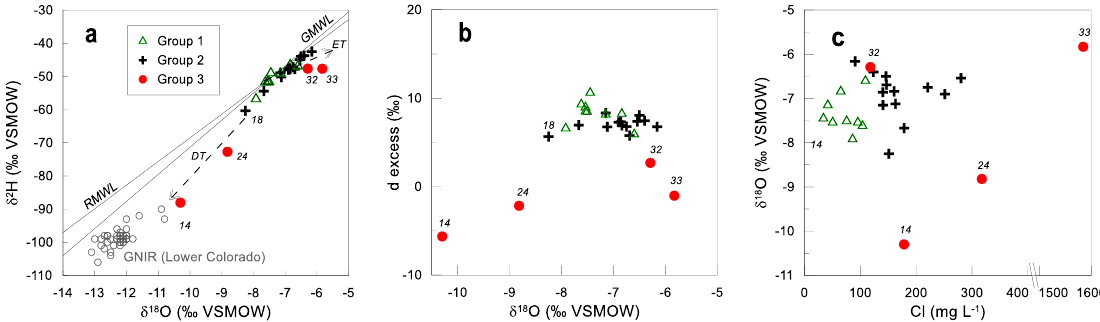
Figure 8. ( a ) δ 18 O and δ 2 H in groundwater from the study area; ( b ) δ 18 O and 2 H excess; ( c ) δ 18 O compared to chloride concentration. Labels indicate selected sample numbers. ET means evaporation trend. DT means dilution trend.